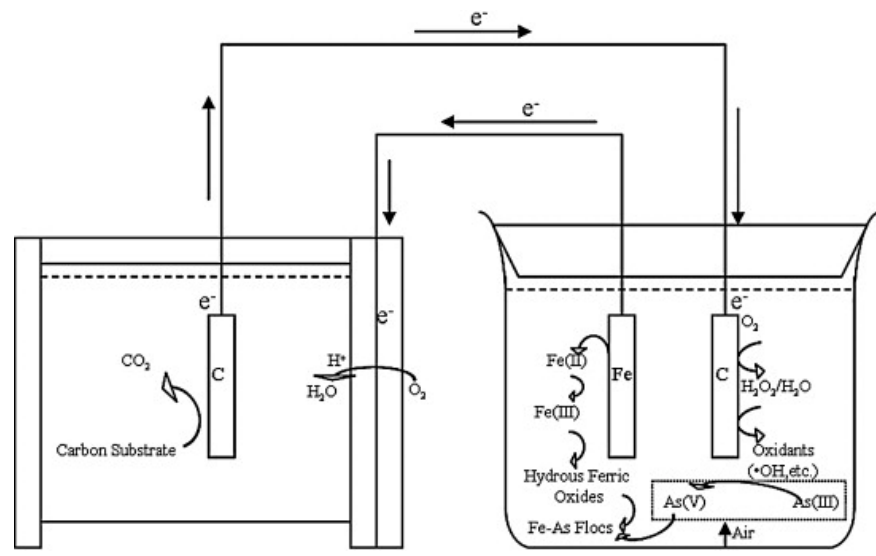
Figure 3. Schematic of the MFC–ZVI (microbial fuel cell–zero valent iron) process. Reprinted from Xue et al. [118] with permission from Elsevier.